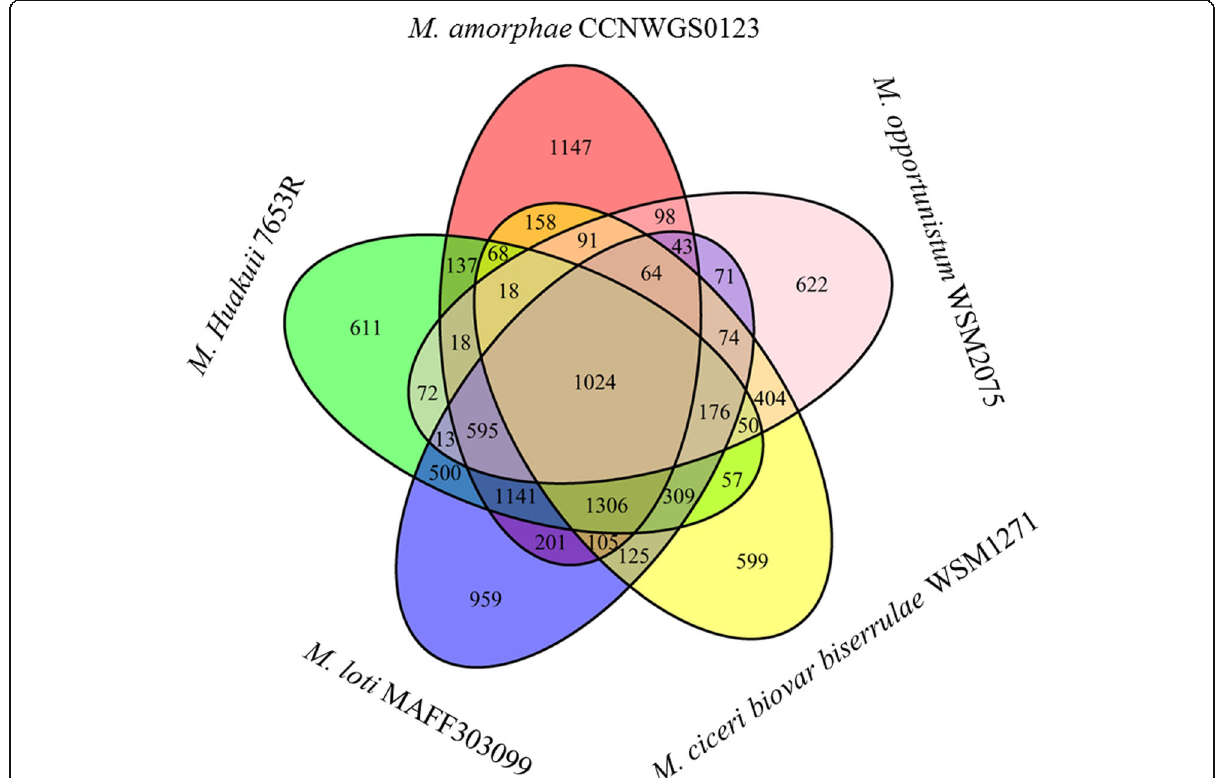
Fig. 4 Core and accessory genome analysis of five Mesorhizobium